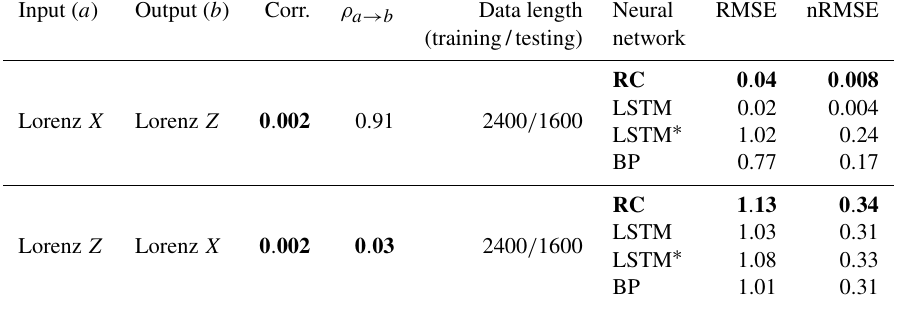
Table 2. Details of Lorenz 63 system reconstruction.